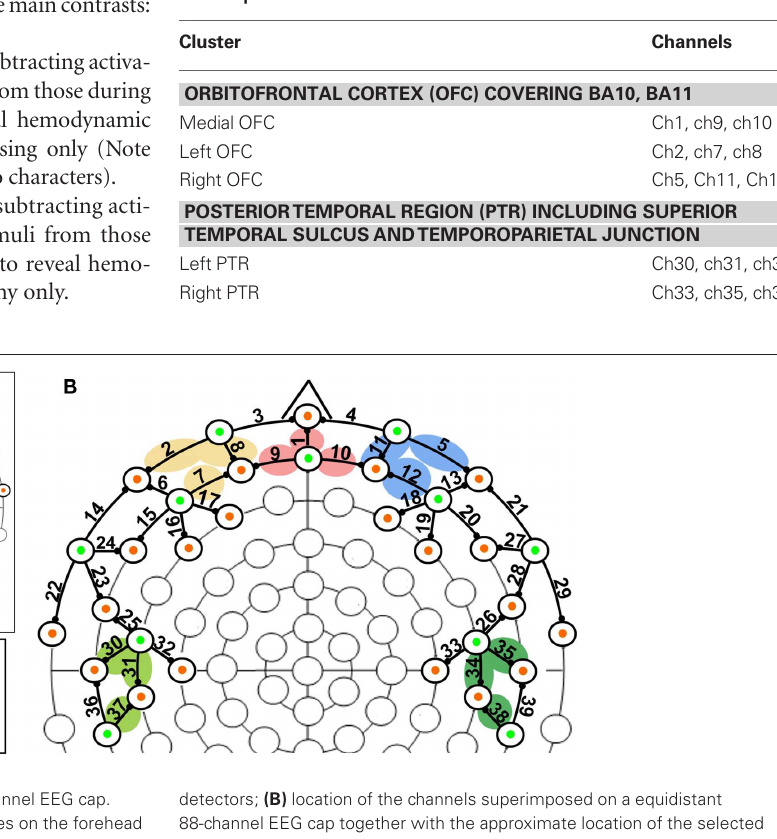
Table 1 | Cluster